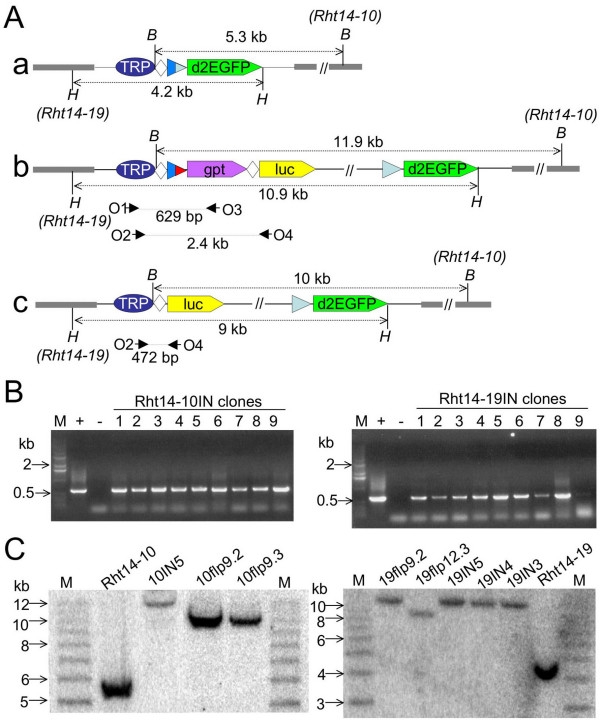
Cre-mediated insertion by ScIn-2. A. Schematic (not to scale) of the target locus in clone Rht14-19 or Rht14-10 before (a) and after (b) Cre-mediated insertion of pIN-2, and after flp-mediate deletion (c). DNA is represented as in Fig. 1 with recognition sites for HindIII (H) and BglII (B) and PCR primers indicated. B. Ethidium bromide stained agarose gel of electrophoresed PCR products generated with the primers O1 and O3 and cell pellets of 9 MPA/Xr, GFP-negative clones selected after transfection of Rht14-10 (Rht14-10IN) or of Rht14-19 (Rht14-19IN) with pIN-2 and pMC-Cre. M = marker DNA. Negative (-) and positive (+) controls used, respectively, no DNA and pTIGHTgpt DNA (expected product: 555 bp). C. Southern blots of genomic DNA isolated from Rht14-10 and derivatives and digested with BglII (left), or from Rht14-19 and derivatives and digested with HindIII (right). Derivatives before (10IN5 and 19IN3, 4 and 5) and after (10flp9.2 and 3 and 19flp9.2 and 12.3) Flp-mediated deletion are analysed. The probe was a fragment of the d2EGFP gene (methods).